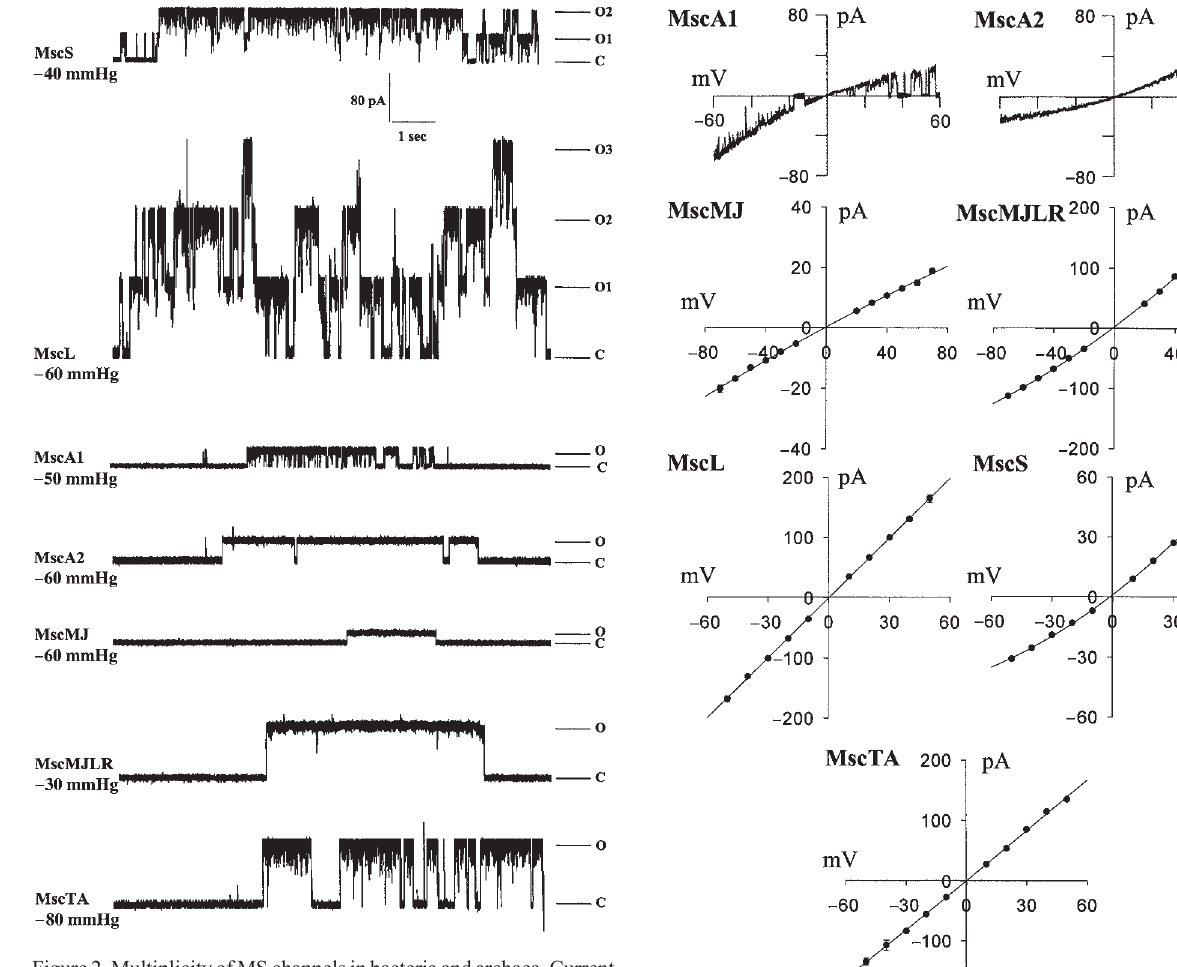
Figure2. Multiplicityof MS channelsin bacteriaand archaea. Current traces(pA) of Escherichia coli MscL and MscS are followed by traces of MscA1 and MscA2 of Haloferax volcanii and MscMJ and MscMJLR of Methanococcus jannaschii . The bottom trace shows the activity of MscTA, the MS channel of Thermoplasma acidophilum . Single channel currents were recorded at +40 mV. Abbreviations: C denotes the closed state; O denotes the open state; and O1, O2 and O3 denote the open state of 1, 2 and 3 channels, respectively. Note: 1 mmHg = 133 Pa.